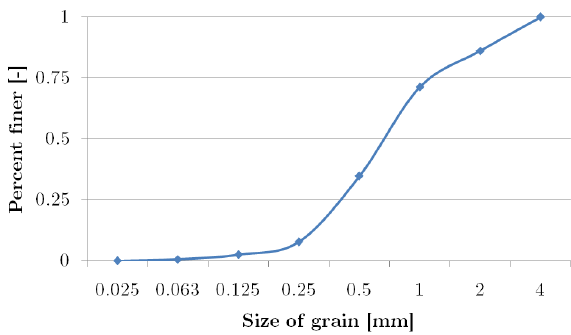
Figure 6. Grain curve of sand.